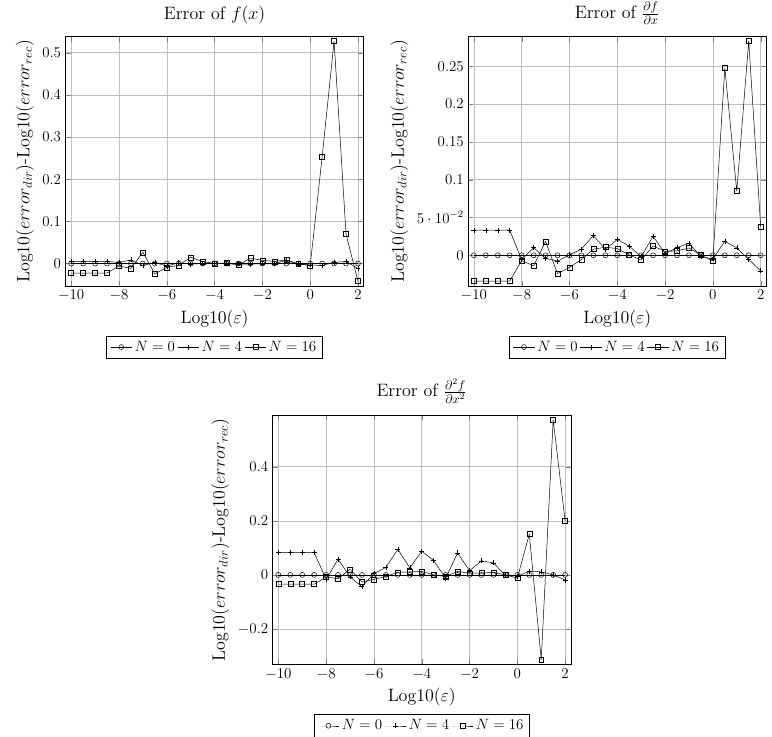
Figure 5. Comparison between direct and recursive approaches by varying ε for a specified function f ( x ) and its first two derivatives. The number of mesh points is fixed at 80 stretched points within the range [ −